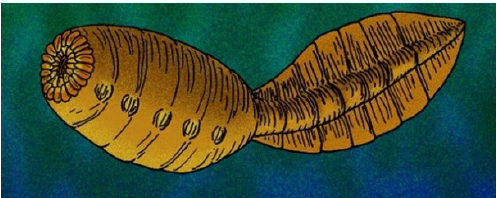
Figure 11. Pomatrum . Stanton F. Fink. Used here per CC BY-SA 2.5.